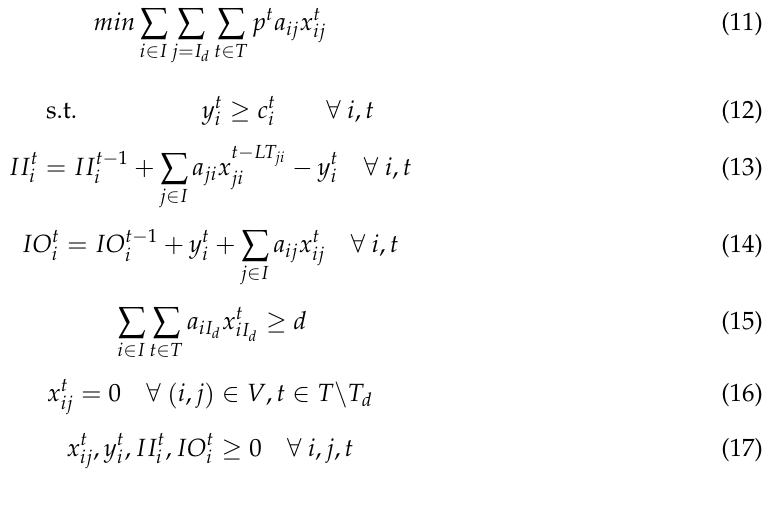
Table 2. Notations for dynamic supply chain